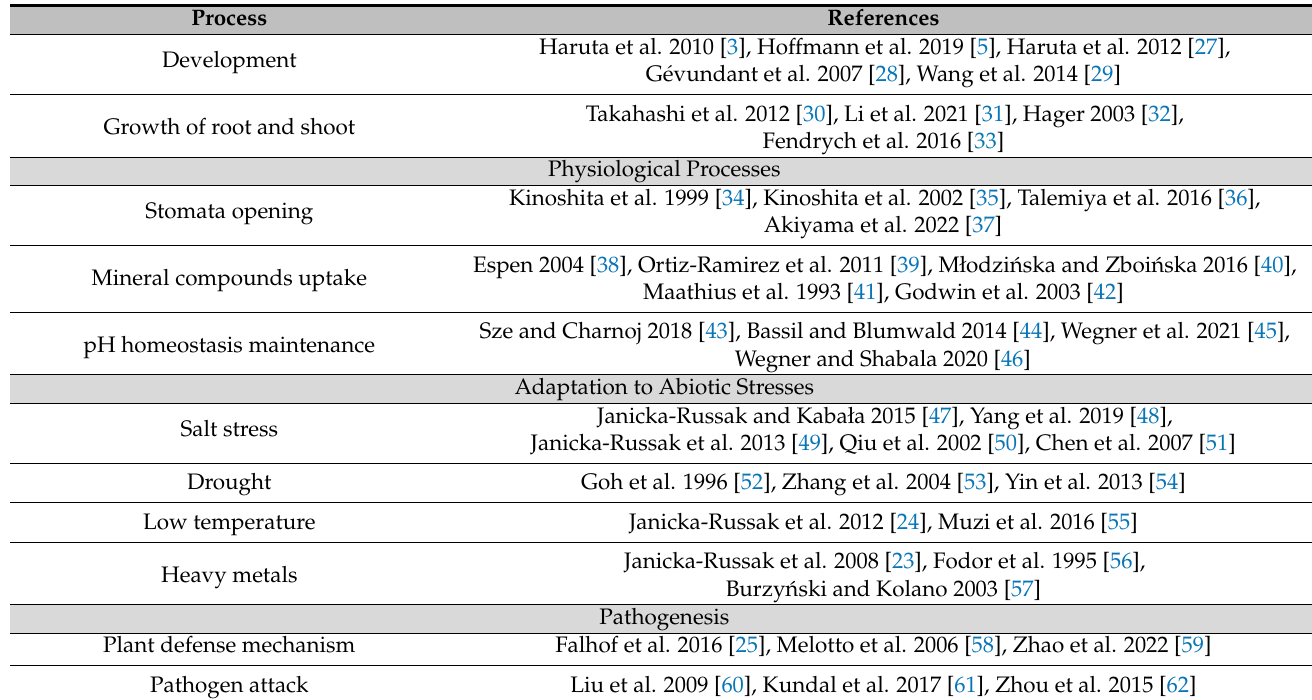
Table 1. The processes in plants are regulated by PM H + -ATPase